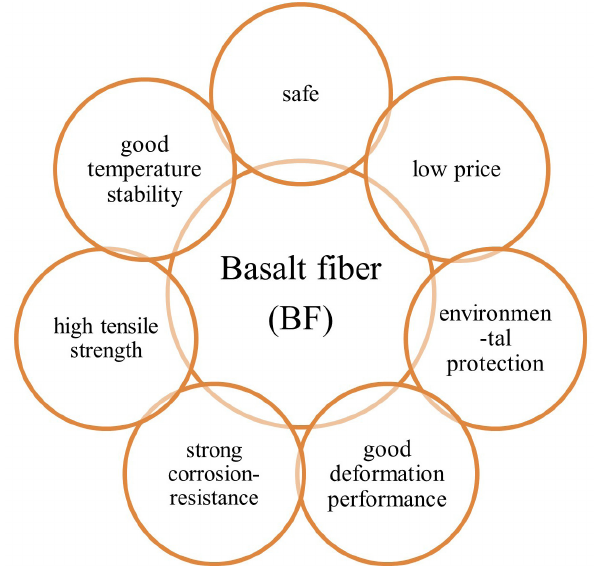
Figure 3: Features of basalt